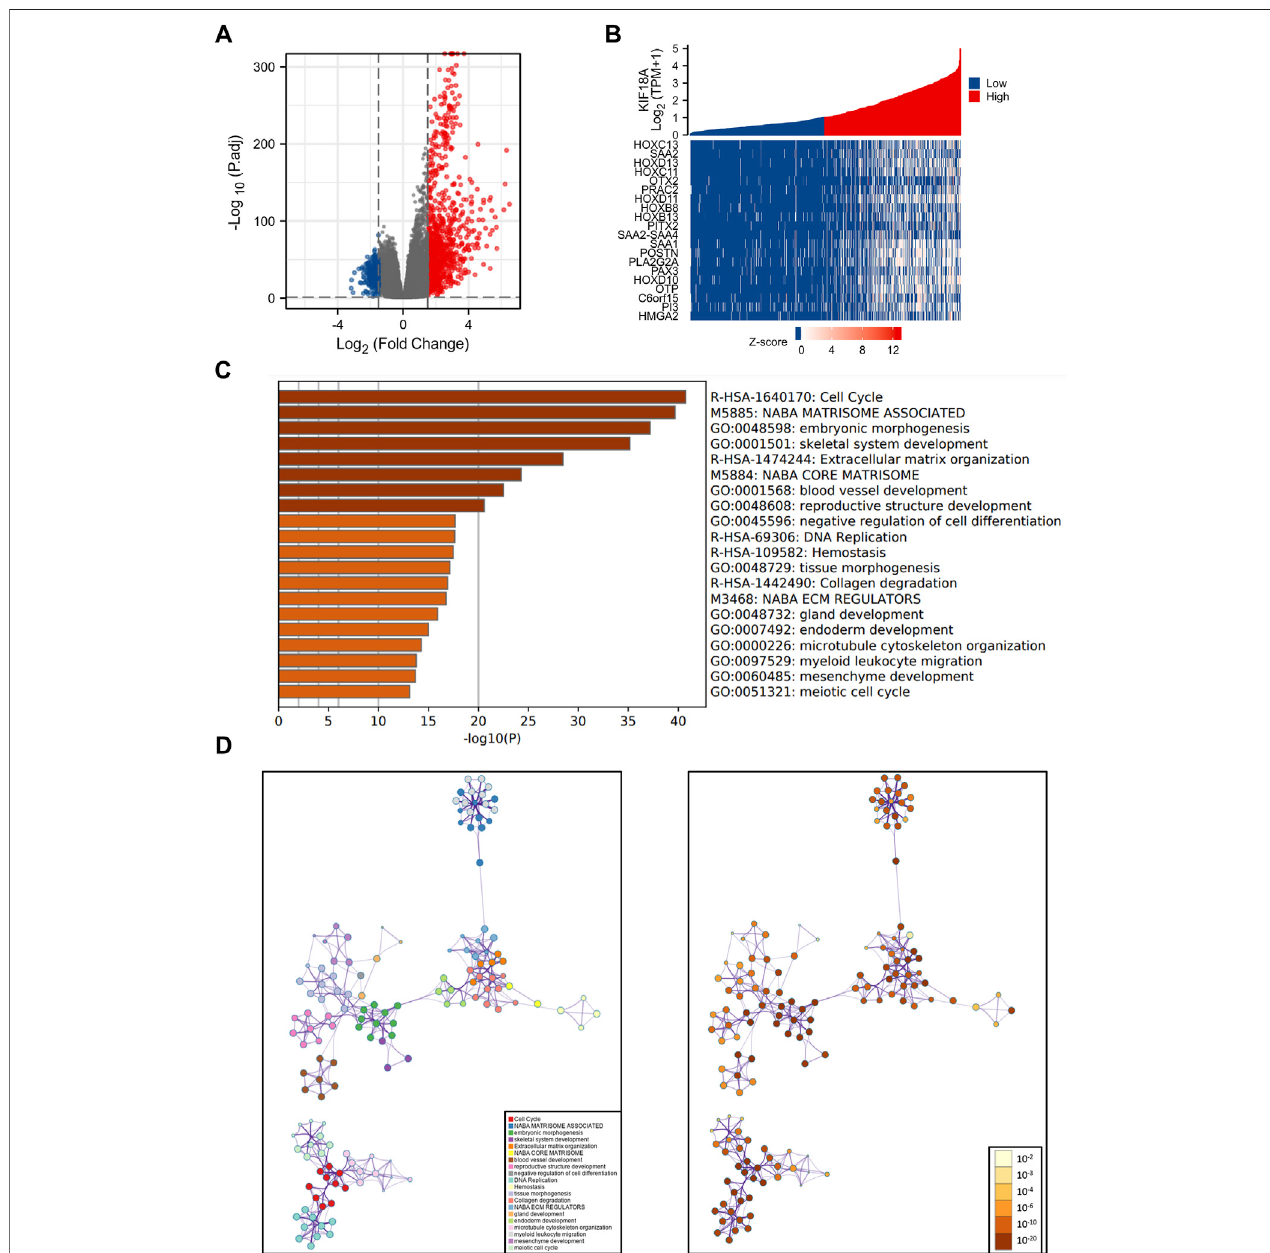
FIGURE 3 | Visualization and functional enrichment analysis of the DEGs between high and low KIF18A expression groups. (A) Volcano plot of the top DEGs. (B) Heat maps of the top 20 DEGs. (C) Bar plot of 20 most relative biological functions enriched terms. (D) Interaction network of 20 most relative biological functions.